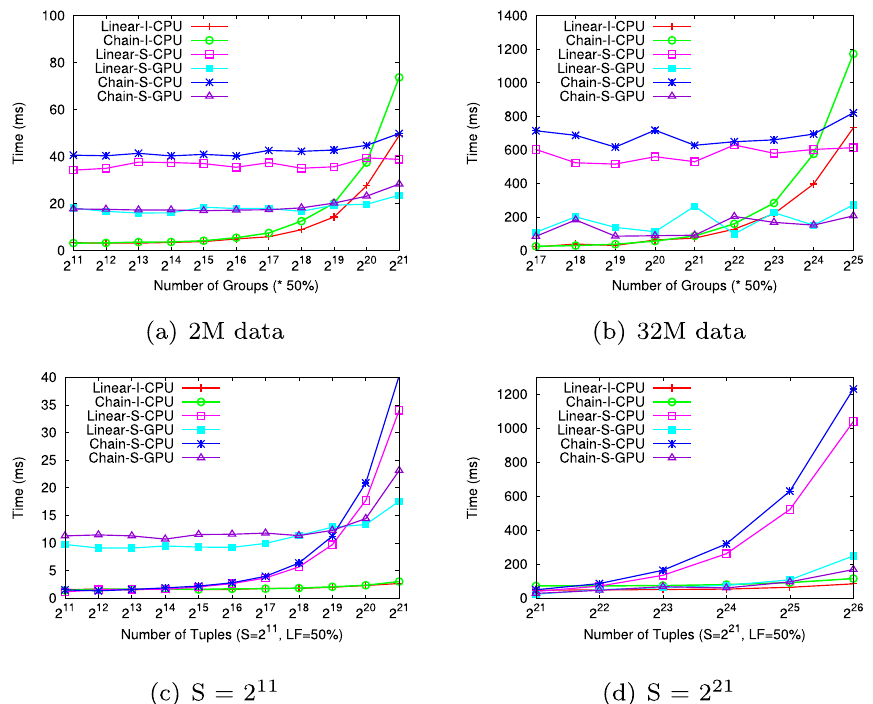
Fig. 12 Performance of various methods on the skewed data which obeys the Zipf distribution with the parameter of